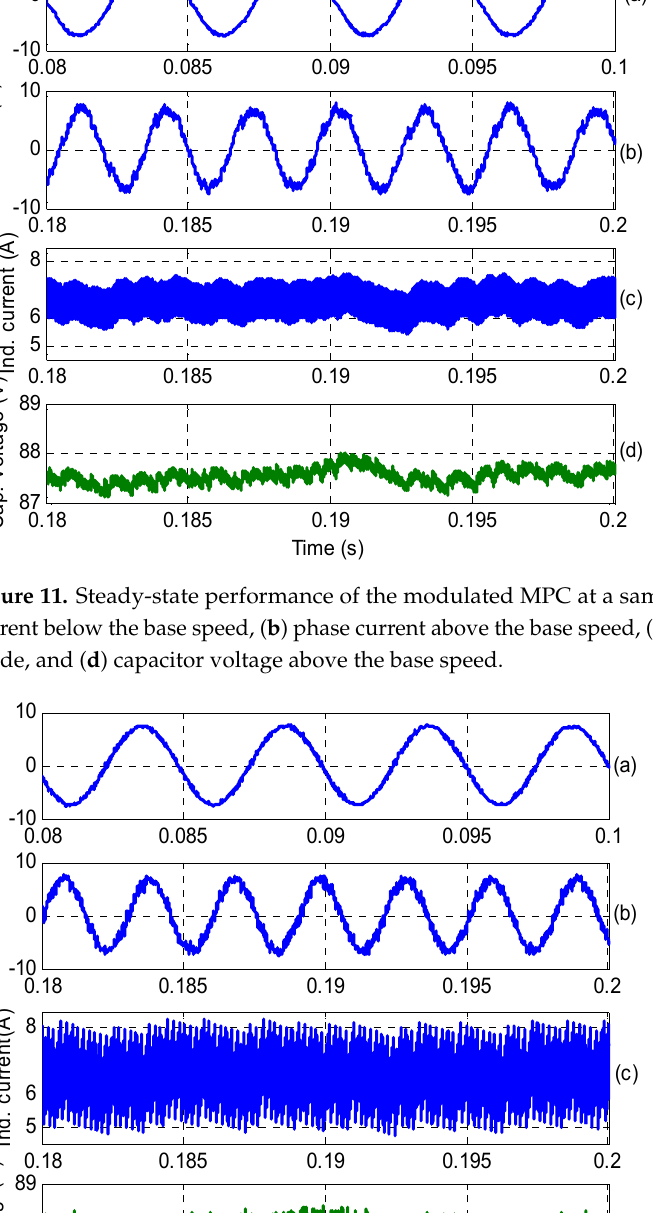
Figure 13. Steady-state performance of the modulated MPC at 40 µs: ( a ) phase current below the base speed, ( b ) phase current above the base speed, ( c ) inductor current in boosting mode, and ( d ) capacitor voltage above the base speed.